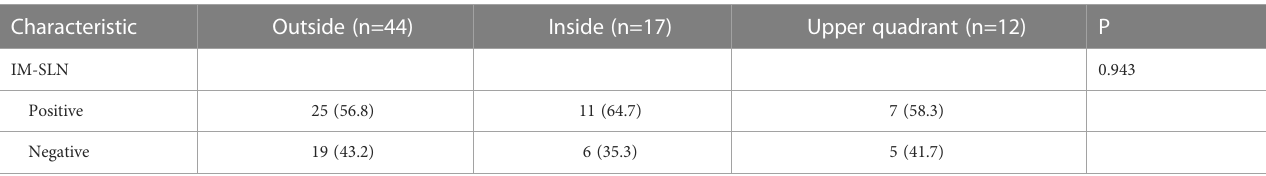
Outside, outer upper quadrant + outer lower quadrant + outer quadrant; Inside, inner upper quadrant + inner lower quadrant + inner quadrant; Upper quadrant, 12 o ’ clock. IM, internal mammary; SLN, sentinel lymph node.